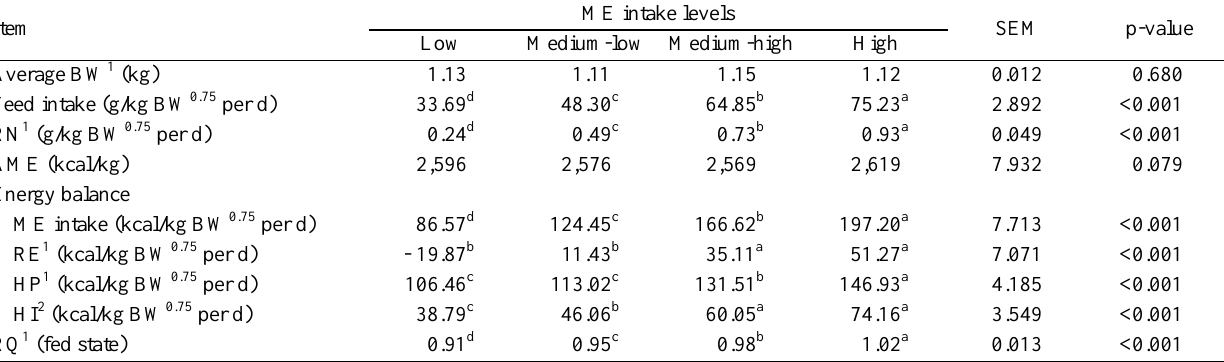
Table 2. Components of energy expenditure in laying hens at four different metabolisable energy intake levels (Mean values with standard errors of the treatment mean for four replicates per ME intake)